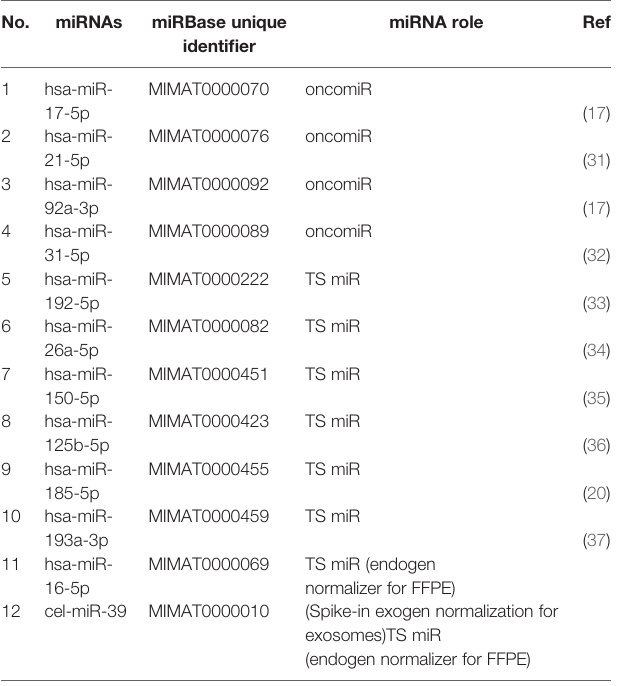
TABLE 1 | MicroRNAs related to colorectal cancer liver